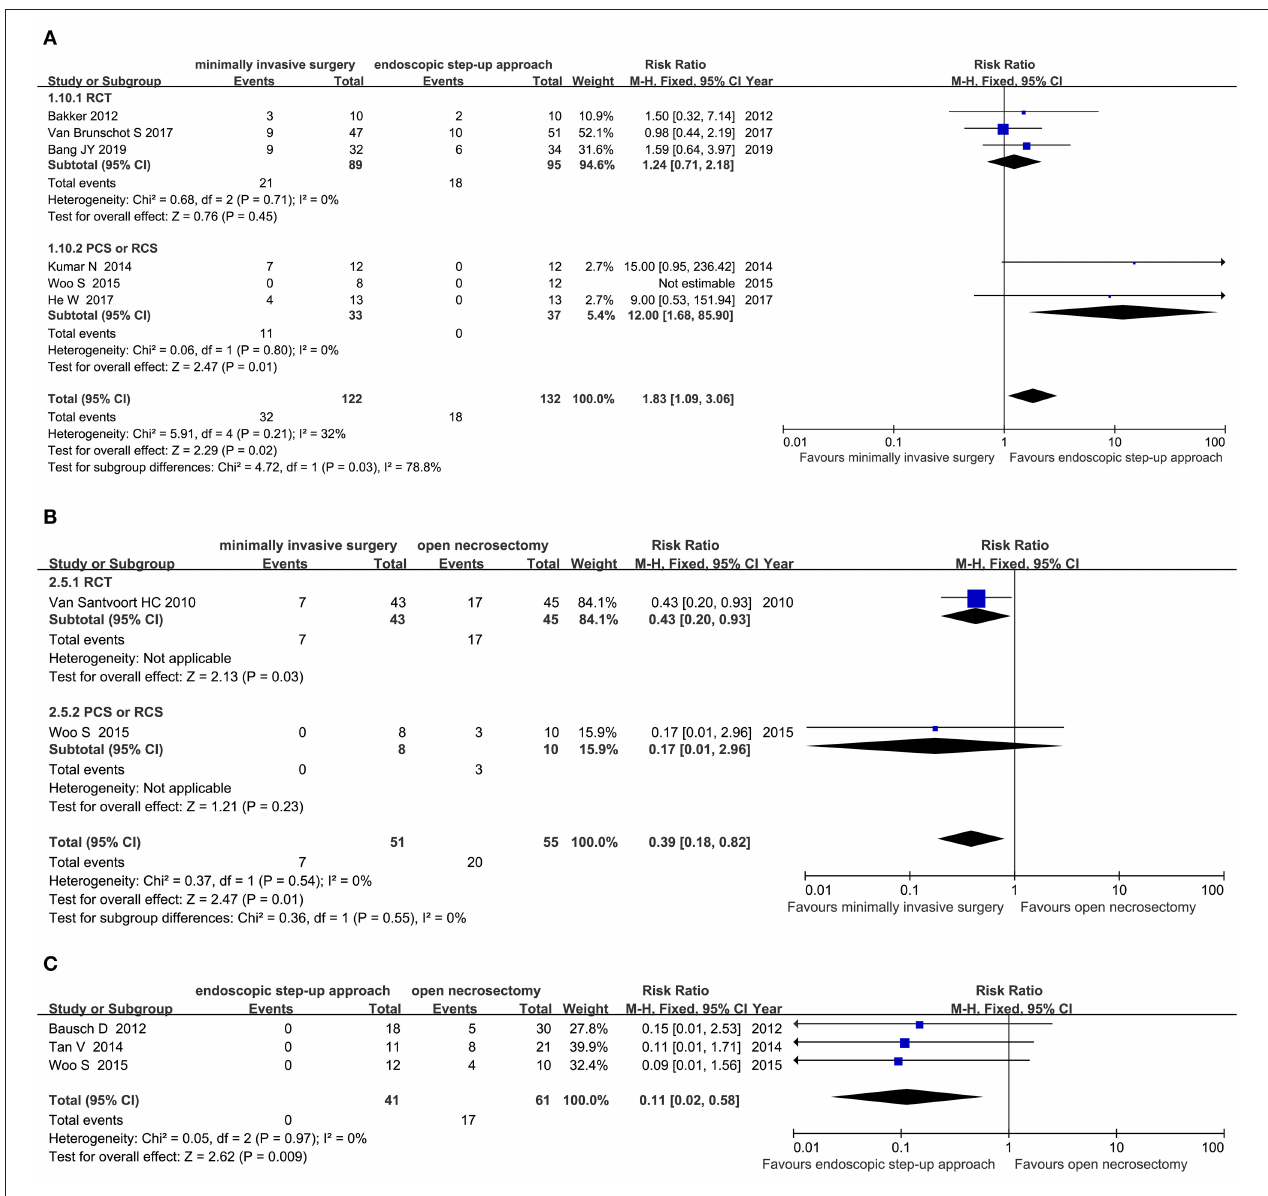
FIGURE 11 | Forest plots for the incidence of endocrine pancreatic insufficiency. (A) Between minimally invasive surgery and endoscopic step-up approach. (B) Between minimally invasive surgery and open necrosectomy. (C) Between endoscopic step-up approach and open necrosectomy. M-H, Mantel–Haenszel test; Fixed, a fixed effects model; CI, confidence